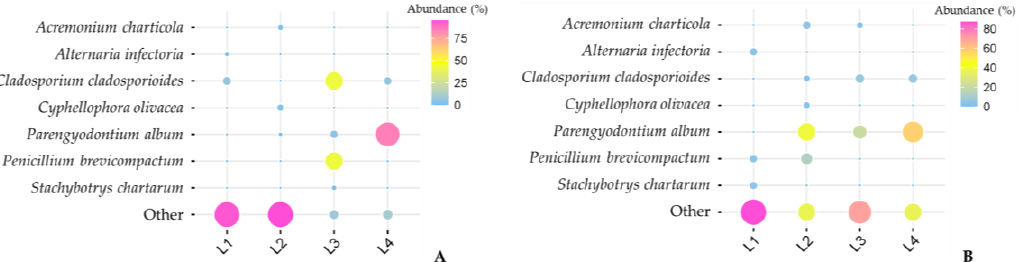
Figure 6. Variations in the relative abundance of shared taxa were obtained from both methods: ( A ) standard freezing incubation; and ( B ) direct plating. ( A ) standard freezing incubation; and ( B ) direct